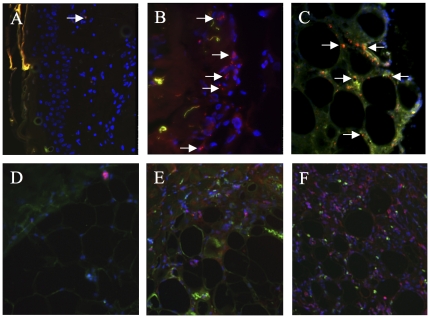
Engraftment of ASCs into the irradiated skin.Location of transplanted ASCs (in red) in the epidermis (A), in the dermis (B), and in the subcutis (C) of skin biopsies centred on injection plots, performed three days after the 3rd graft, on day 70. Brightly red fluorescing quantum dots marked ASCs (arrows) around blue nuclei (DAPI) near the cutis/subcutis border and among adipose tissue. The immunostaining of CD3 and lambda light chains (in pink) in the subcutis of healthy (D), PBS-treated (F), and ASC-grafted (F) skin underlined the infiltration by T and B lymphocytes three days after the ASC graft. Magnification: ×100.”